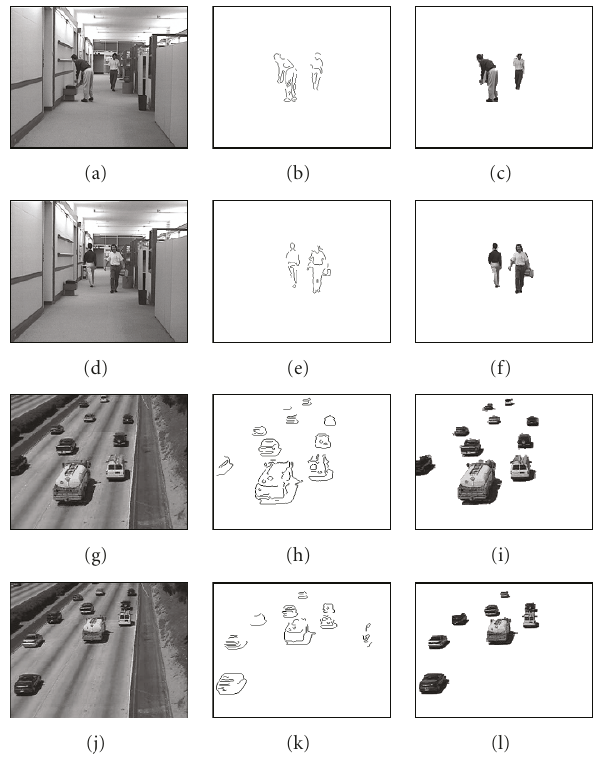
Figure 11: Results obtained from “Hall Monitor” and “Highway” video sequences by the proposed method. (a) I 133 “Hall Monitor”; (b) edge image of I 133 ; (c) segmented moving object of I 133 ; (d) I 210 “Hall Monitor”; (e) edge image of I 210 ; (f) segmented moving objects of I 210 ; (g) I 36 of “Highway”; (h) edge image of I 36 ; (i) segmented moving object of I 36 ; (j) I 61 of “Highway”; (k) edge image of I 61 ; (l) segmented moving objects of I 61